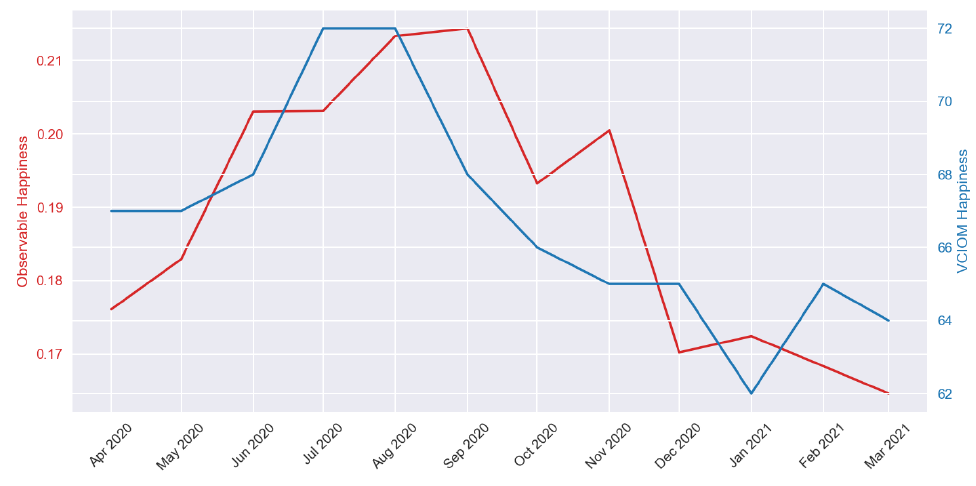
Figure 3. Observable happiness (~270,000 users per month) and VCIOM Happiness (1600 respondents per month) indicators for a period from April 2019 to March